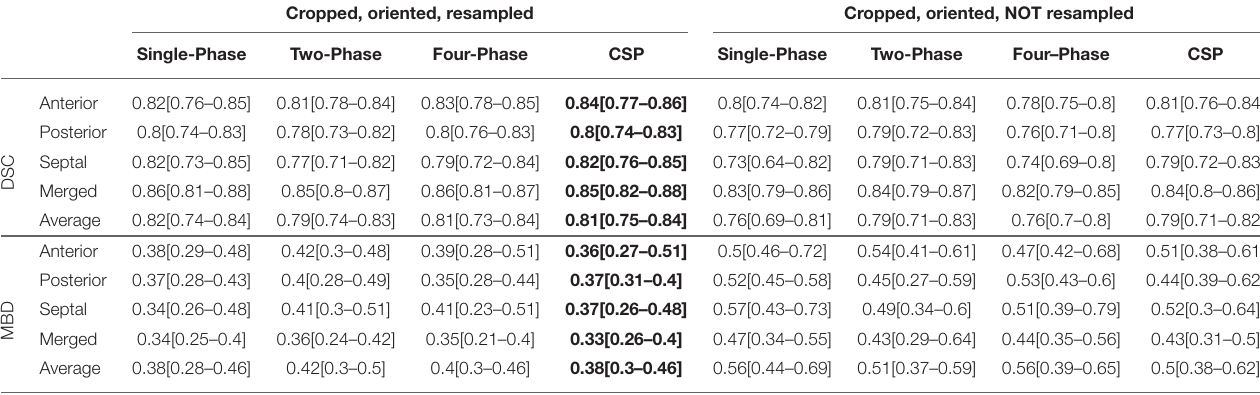
TABLE 4 | Inference results using annular curve input and commissural landmarks across all stages of